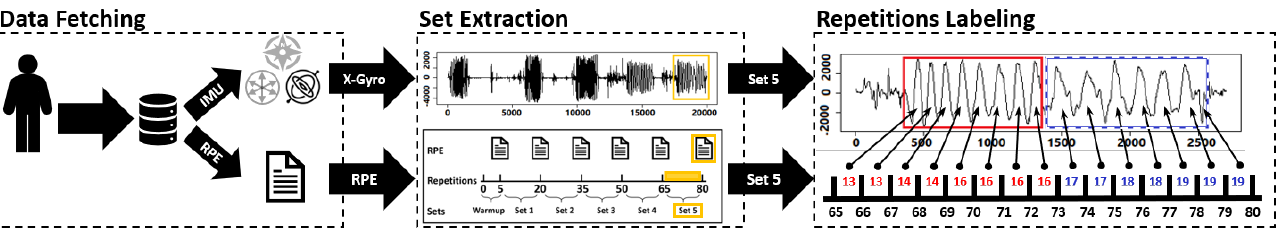
Figure 2. A visual example of extracting and labeling repetitions of the fifth set from the gyroscope’s X -axis.